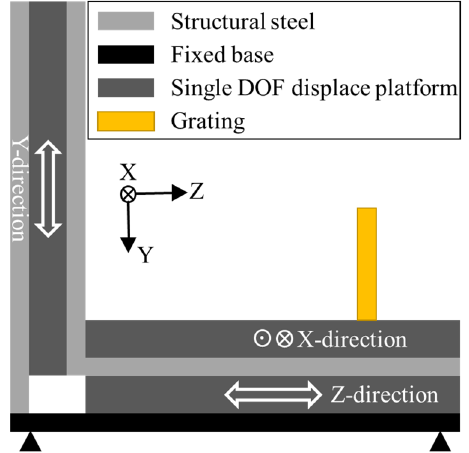
Figure 4. Displacement driver designed for the three-DOF reading head.